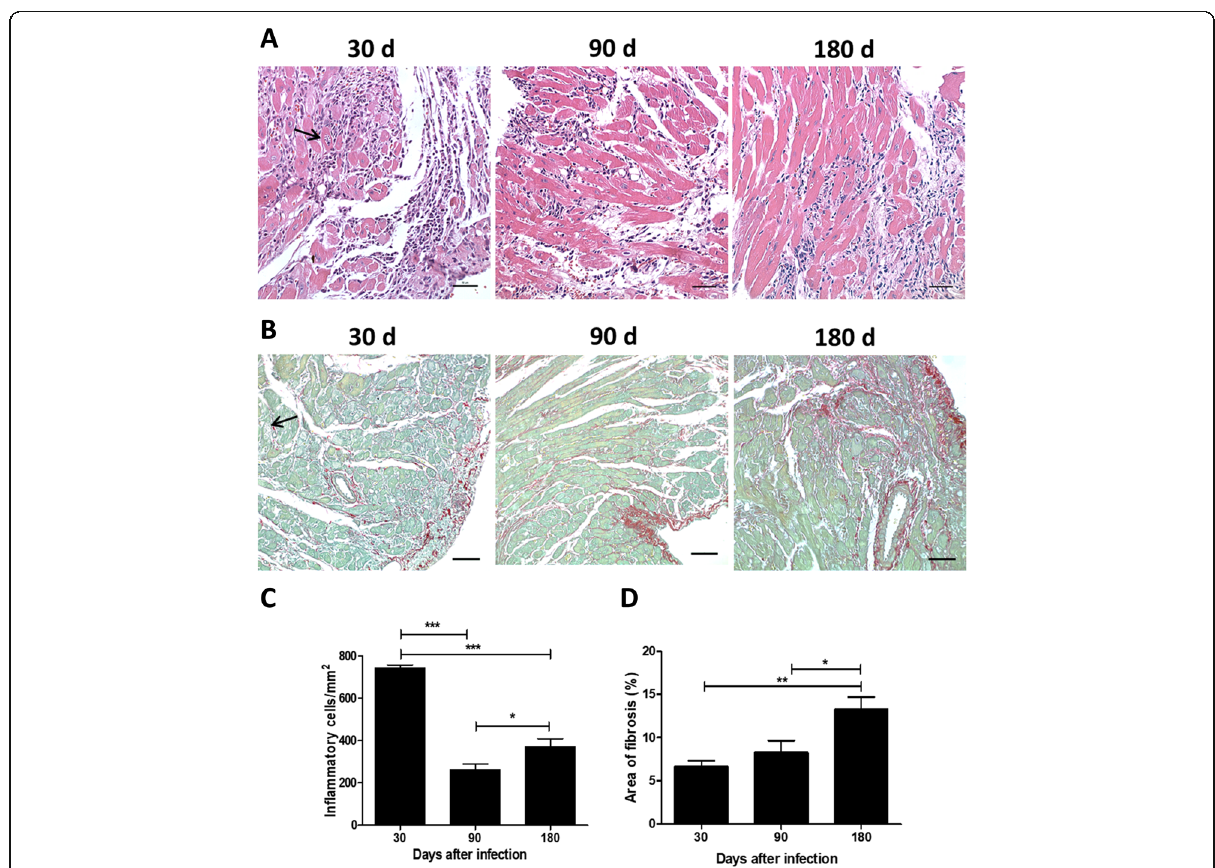
Fig. 1 Histopathological analysis of mouse hearts at different time points after infection. a , Heart sections stained with H&E, showing the presence of inflammatory infiltrate at 30, 90 and 180 days after infection with T. cruzi . b , Heart sections stained with Sirius red, showing areas of fibrosis at 30, 90 and 180 days after infection with T. cruzi . Arrows indicate the presence of parasite nests in the acute phase (30 days of infection). c and d , Quantification of inflammation and fibrosis by morphometric analysis in the hearts of infected mice. Data represent the mean±SEM of 5 – 6 mice/ group. * P <0.05; ** P <0.01; *** P <0.001. Calibration bars=50 μ